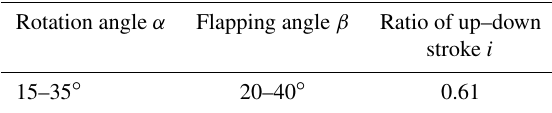
Figure 1. Schematic diagram of coordinate systems and wing kine- matics. Table 1. The flight parameters of flapping